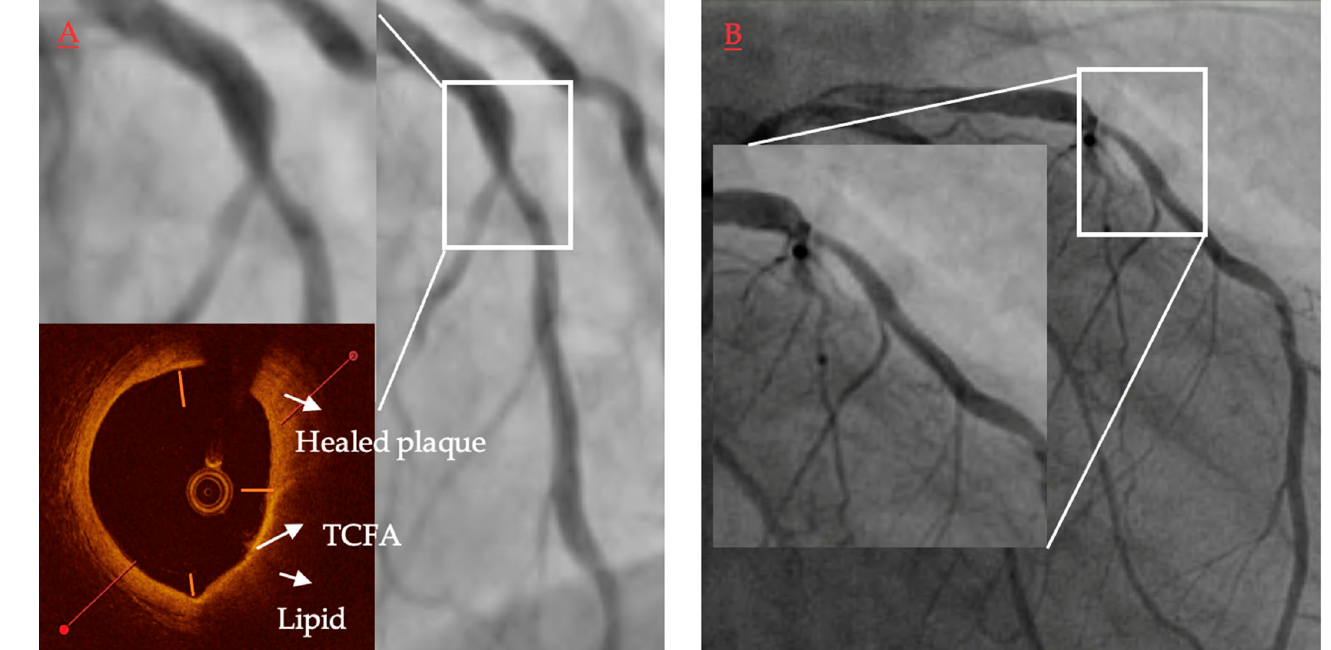
Figure 5. Representative case of vulnerable plaque progression. ( A ) Thin-cap fibroatheroma (TCFA) located in a short lesion in left anterior descending, diameter stenosis 62%, FFR baseline 0.86. Presence of a TCFA 3 ‒ 6 o’clock adjacent to a healed plaque 12 ‒ 3 o’clock. ( B ) Same lesion 13.5 months later when patient presented with non-ST-elevation myocardial infarction and underwent revascularization.